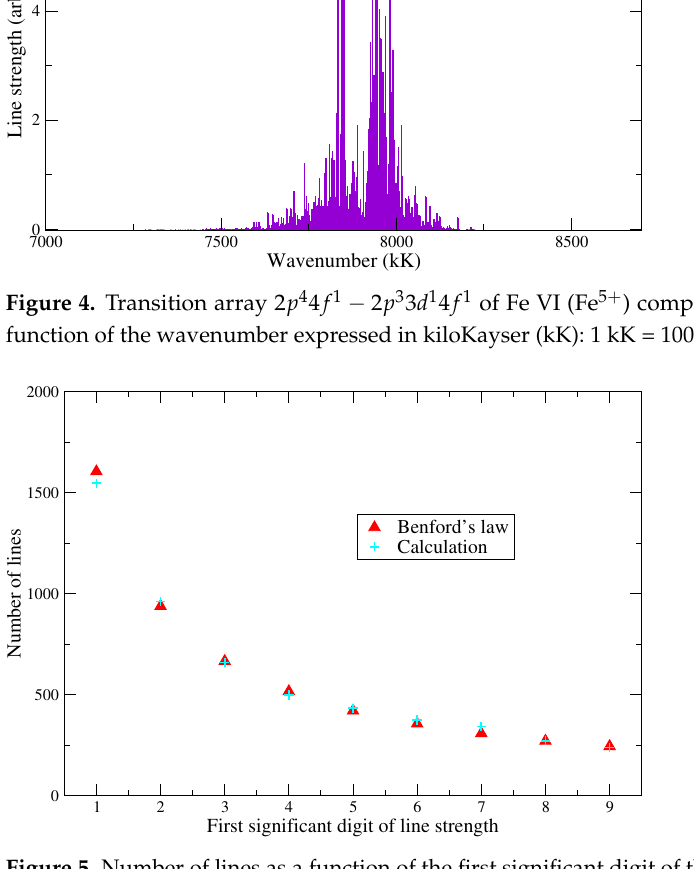
Figure 5. Number of lines as a function of the first significant digit of their strength for the transition array Fe VI 2 p 4 4 f 1 2 p 3 3 d 1 4 f 1 −